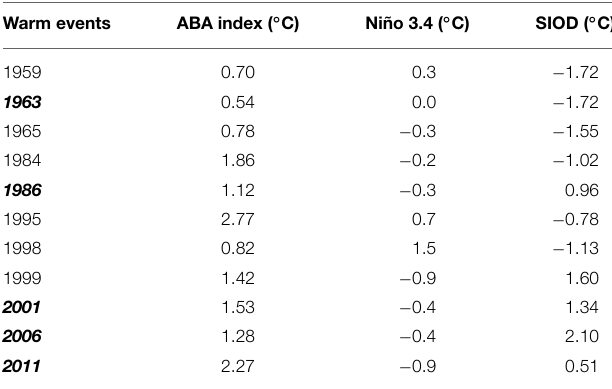
Frontiers in Environmental Science |